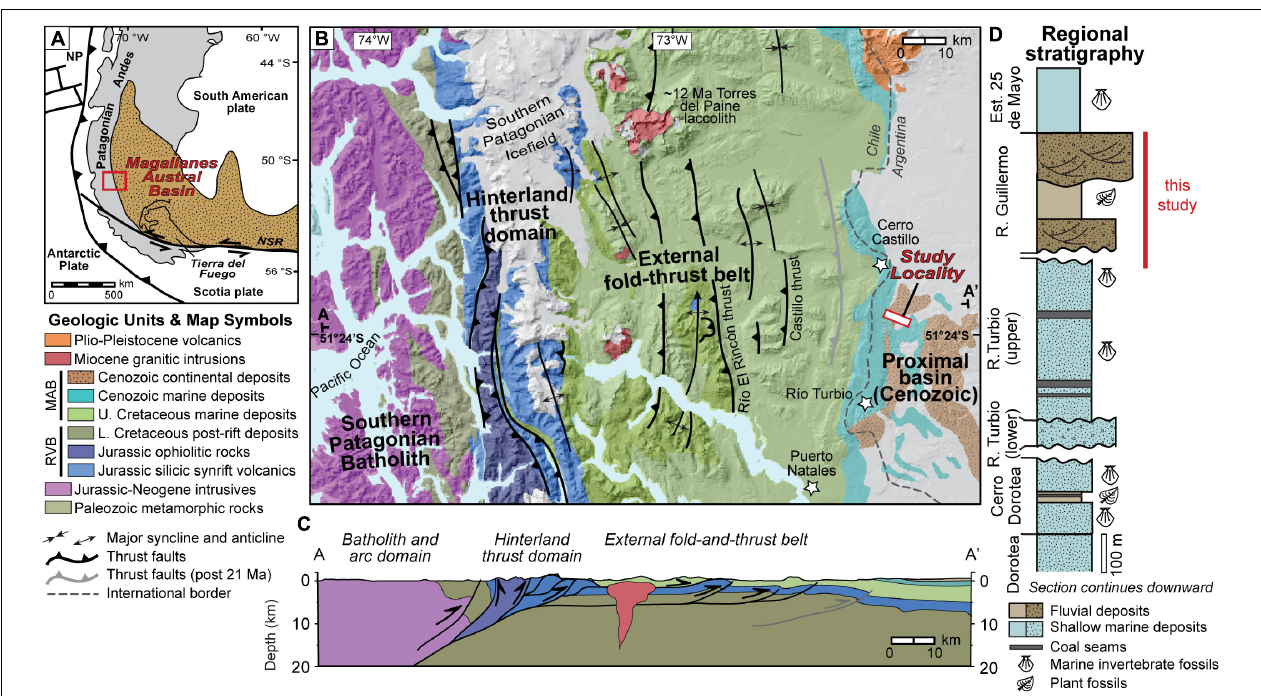
FIGURE 1 | (A) Location of the Patagonian Andes retroarc orogenic belt and foreland basin system. NP, Nazca plate; NSR, North Scotia Ridge. (B) Geologic map compiled from Malumián et al. (2000), SERNAGEOMIN (2003), and Fosdick et al. (2011). The hinterland thrust domain includes faulted and folded rocks of Jurassic Sarmiento Ophiolitic Complex and Tobífera Formation. The external fold-and-thrust belt comprises the Zapata, Punta Barrosa, Cerro Toro, Tres Pasos, and Dorotea formations. MAB, Magallanes-Austral Basin; RVB, Rocas Verdes Basin. (C) Simplified regional cross-section showing major structural features of the Patagonian Andes (modified from Fosdick et al., 2011, 2013). (D) Regional stratigraphy of the study area showing Upper Cretaceous – Neogene strata (adapted from Fosdick et al., 2019). See text for